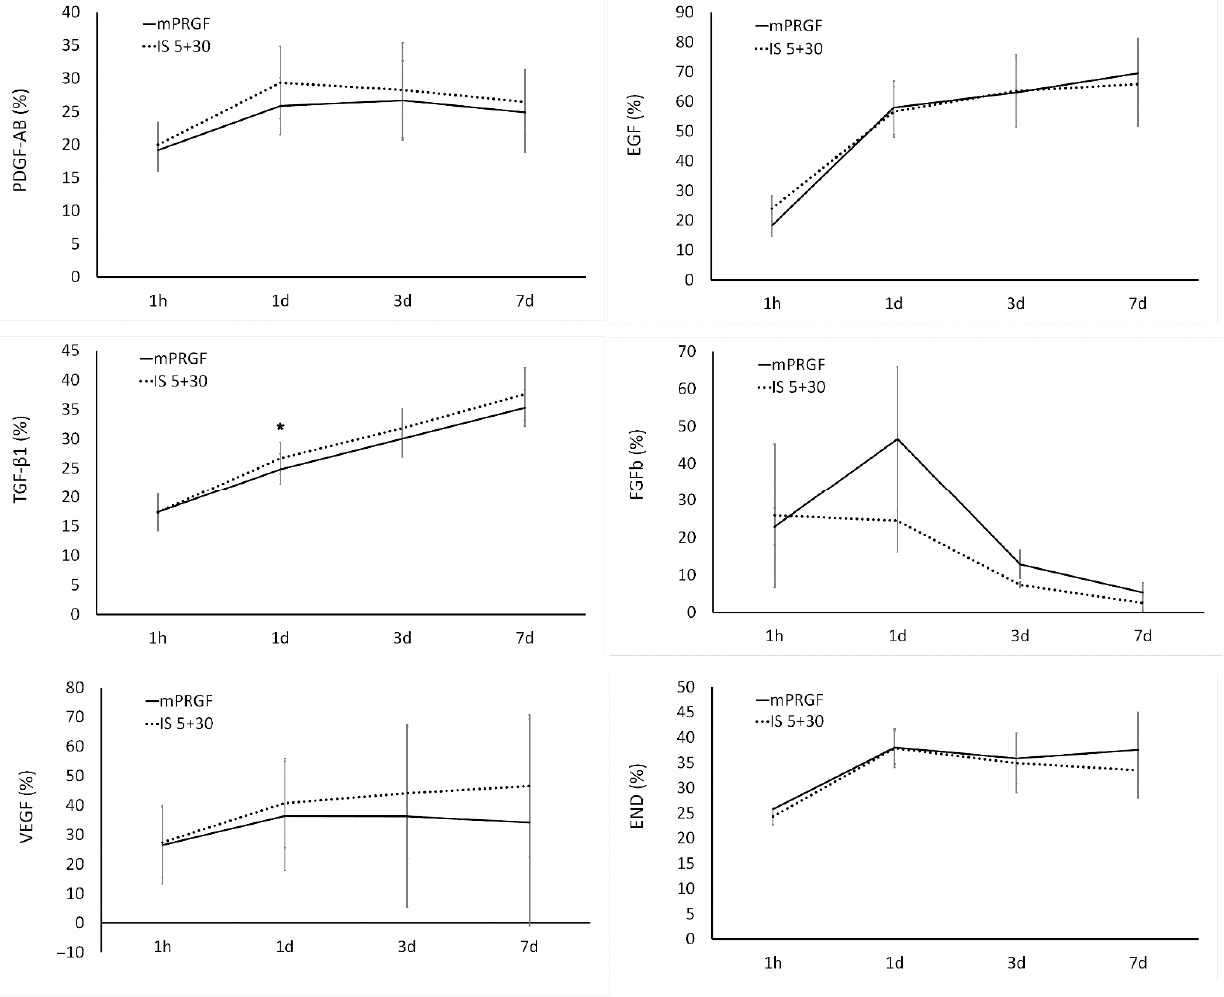
Figure 3. The release kinetics of PDGF-AB, EGF, TGF- β 1, FGFb, VEGF, and END were analyzed in both PRGF membranes (mPRGF and IS5+30) for 1 h and 1, 3, and 7 days. Except for TGF- β 1 levels at 1d, no significant differences were found between the IS5+30 and mPRGF at any study time points in any of the growth factors evaluated. * p < 0.05 significant differences between mPRGF and